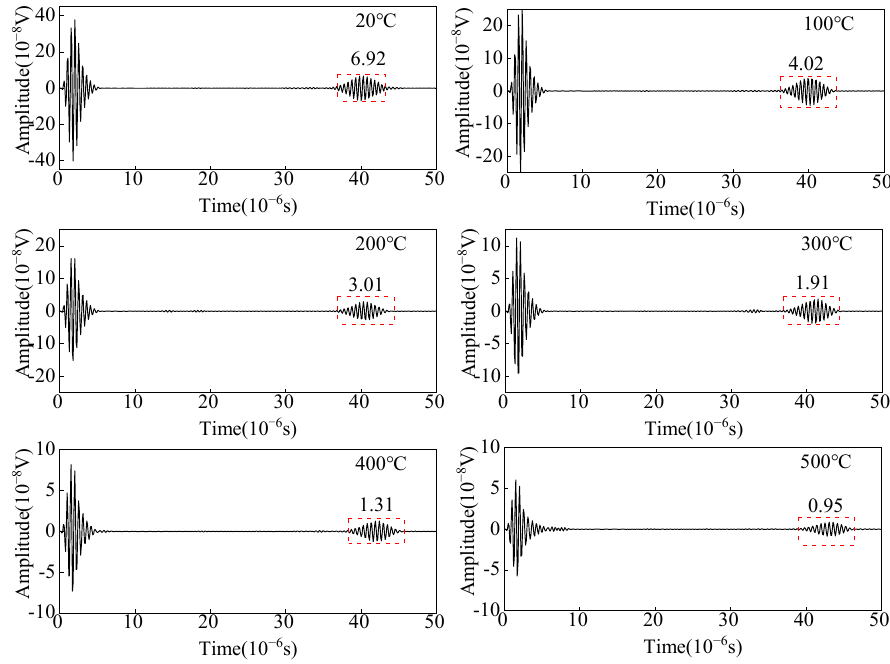
Figure 13. Detected ultrasonic wave signal obtained by the circuit-field coupled FE model of the angled SV waves EMAT.